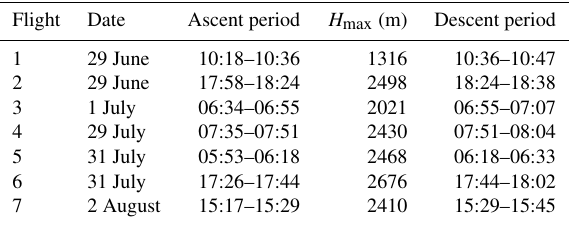
Table 1. The ascent and descent flight time (local time, LT) and the maximum height.